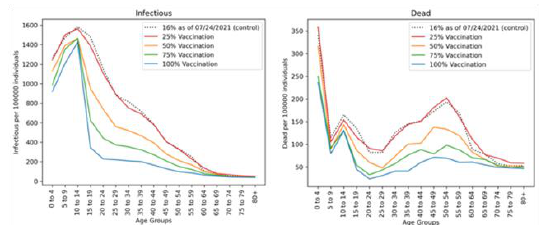
Figure 6: Vaccination Sensitivity Analysis